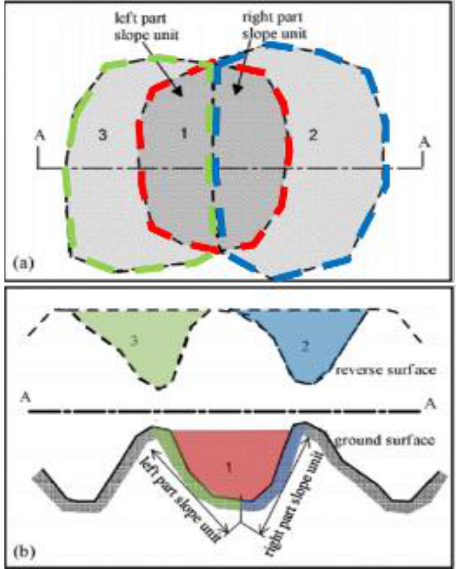
Figure 2. Slope units processing. (Xie et al.,